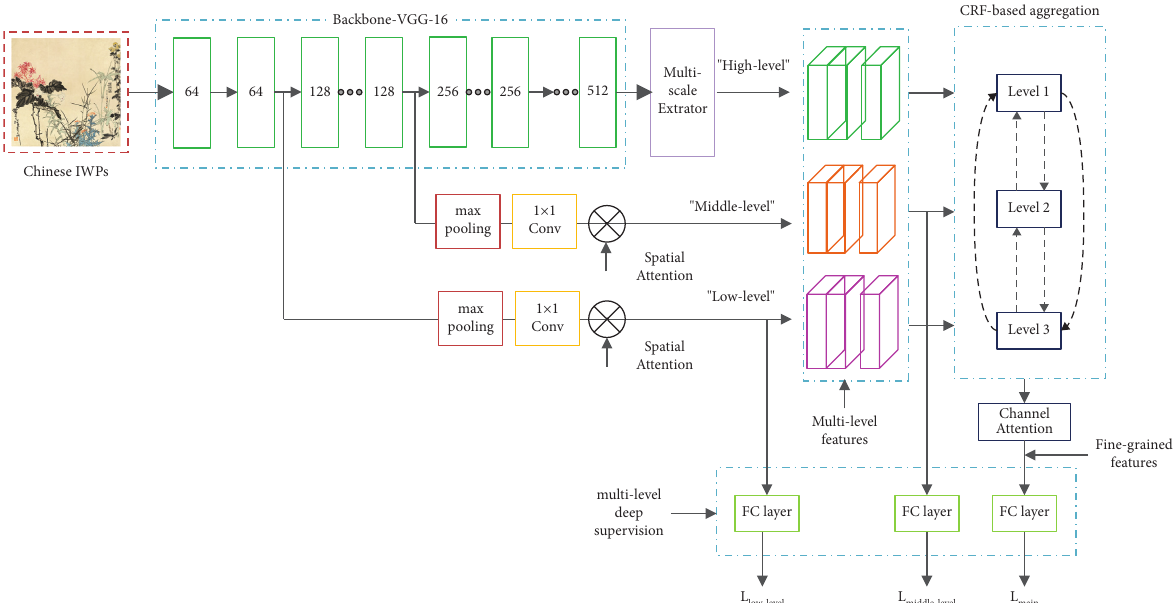
Figure 1: The proposed model for author classification of Chinese IWPs by multi-level attention and multi-scale